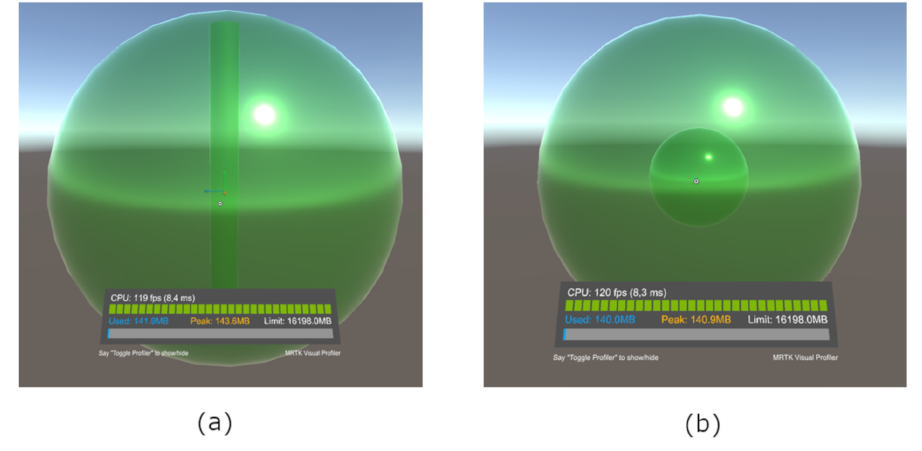
Figure 3. Projected workspace: ( a ) Universal Robots UR5. ( b ) ABB IRB